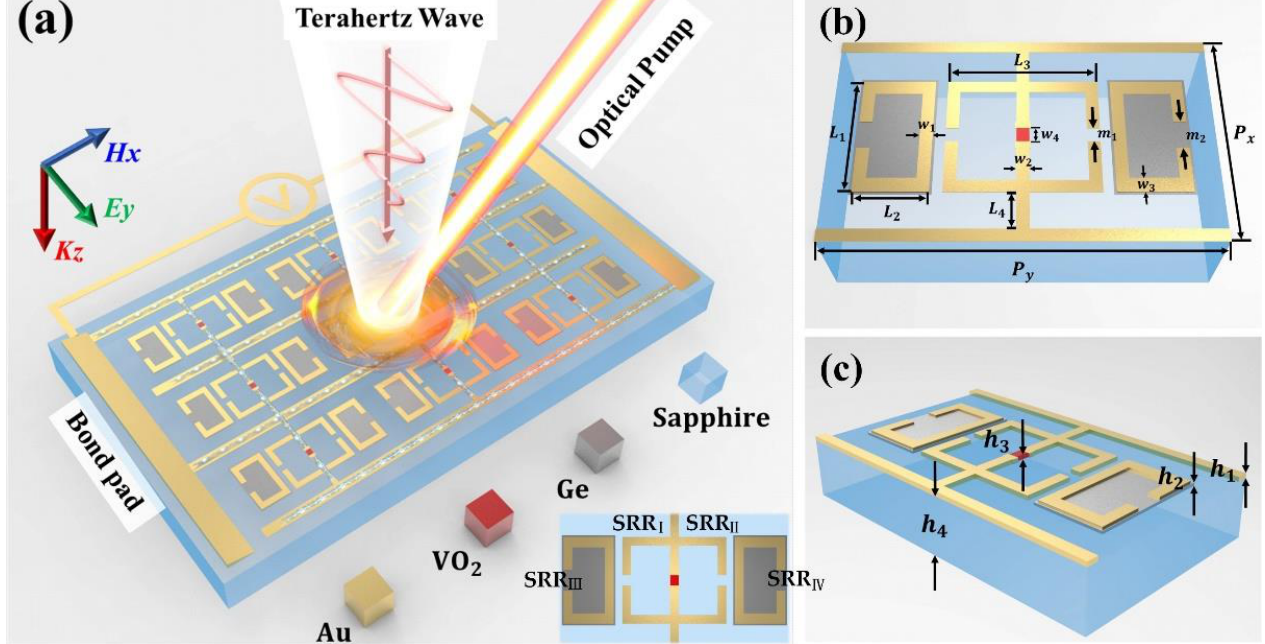
Figure 1. Schematics and working principle of the proposed hybrid metasurface. ( a ) Schematic illustration of the metasurface; the phase change material VO 2 and the semiconductor material Ge are controlled by external voltage and the optical pump, respectively. ( b , c ) The detailed parameters of the unit cell.